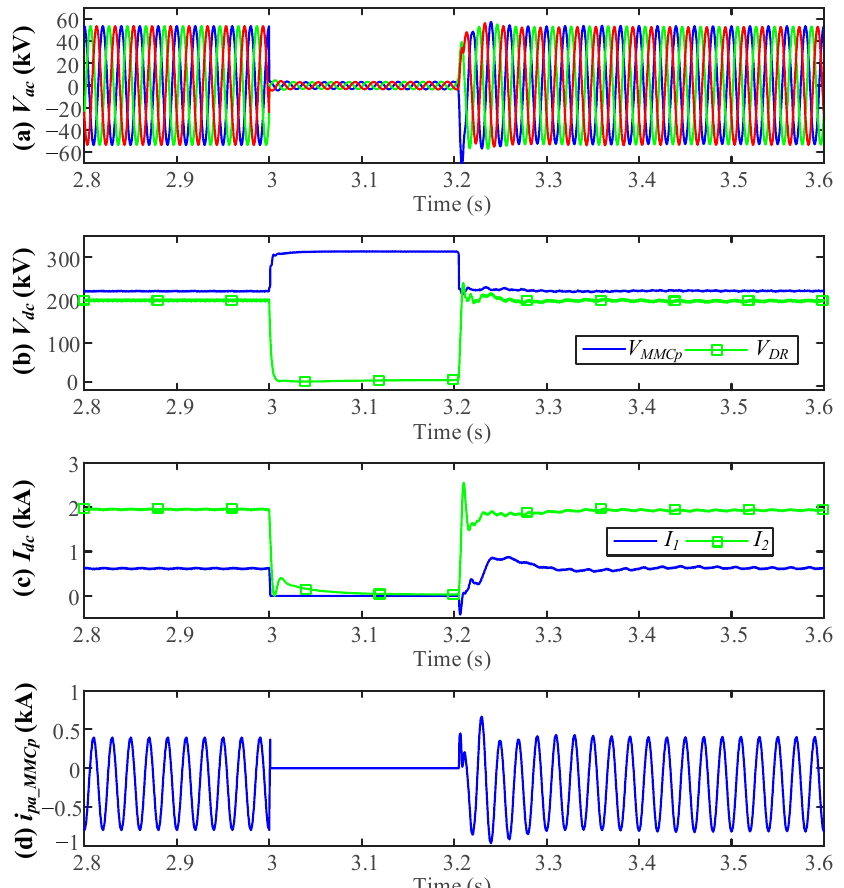
Figure 7. System performance to AC fault in V dc -V ac control mode: ( a ) AC voltage; ( b ) DC voltage; ( c ) DC current; ( d ) Phase A MMC p upper arm current.